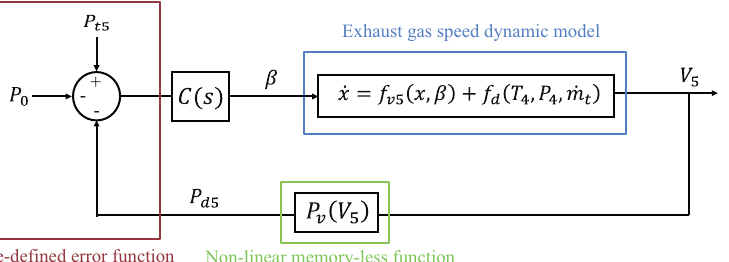
Figure 5. Controller structure considering the Wiener-model representation of the dynamic pressure. The nozzle constriction angle β is the only mean for directly actuating over the flow speed in the nozzle while f d can be considered as input perturbations.